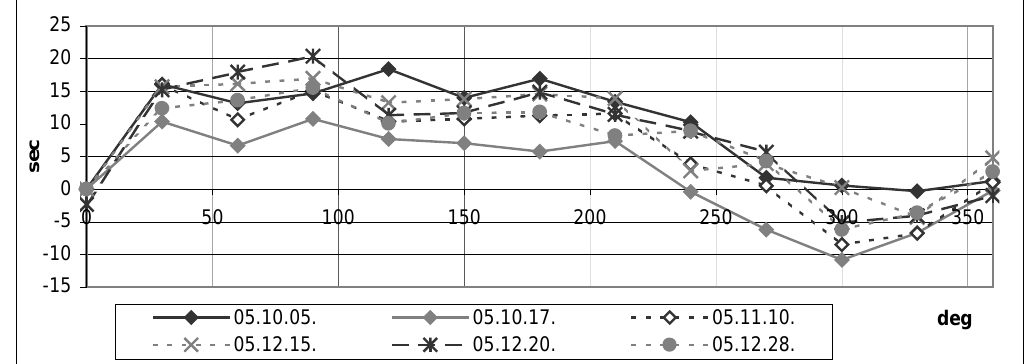
Fig 3 . Graphs of readings of the photoelectric autocollimator (different dates)